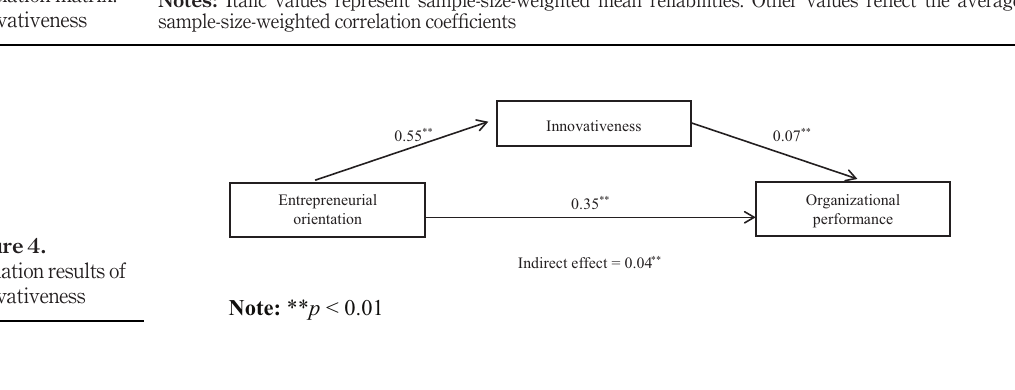
Figure 3. Mediation results of learning orientation